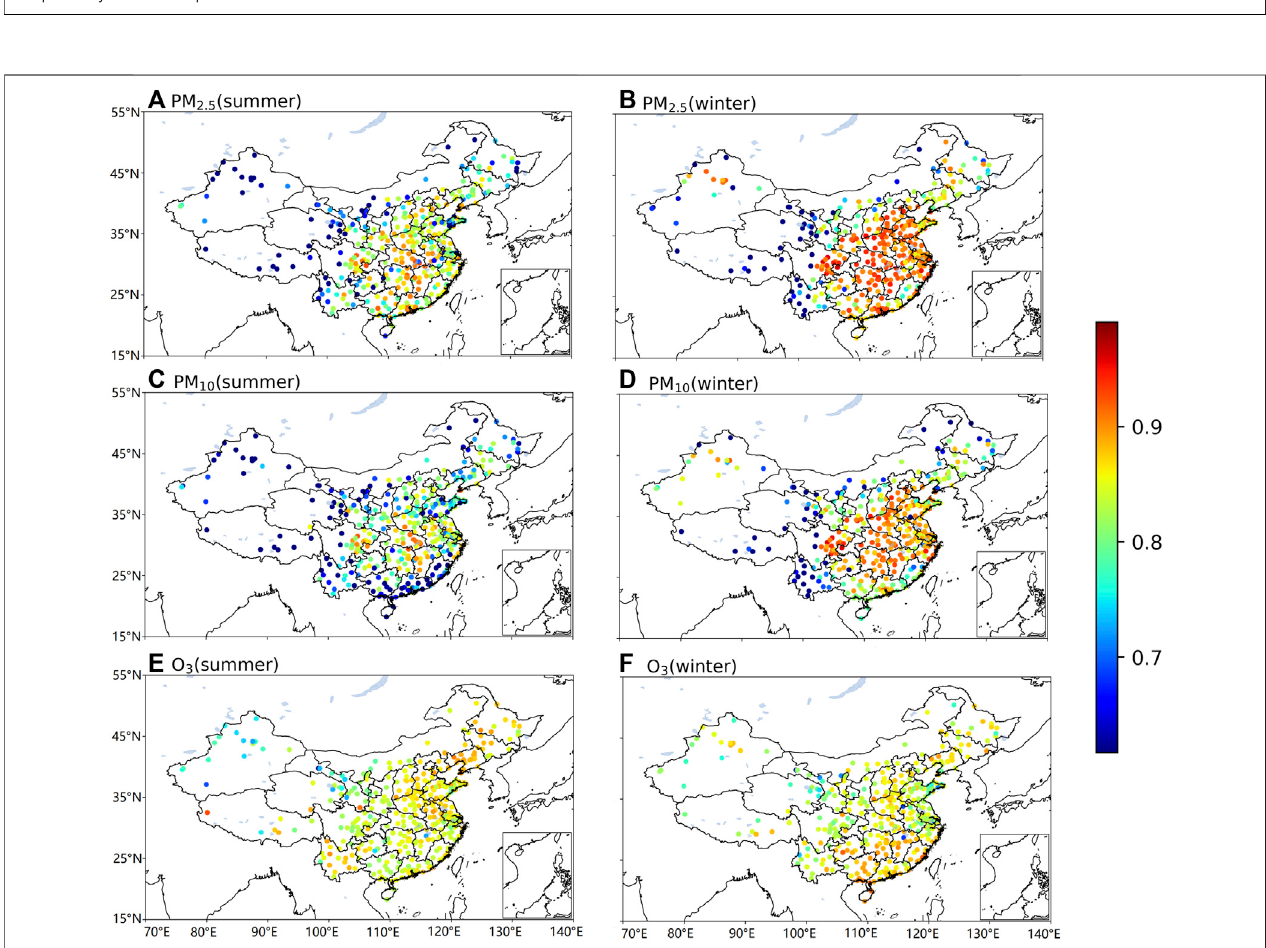
Frontiers in Physics |